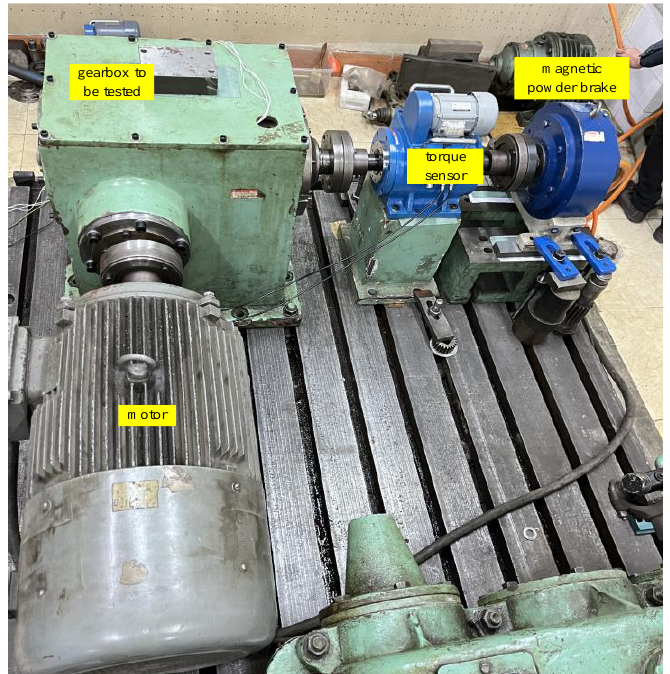
Figure 4. Installation diagram of the torque sensor on the gear test bench.